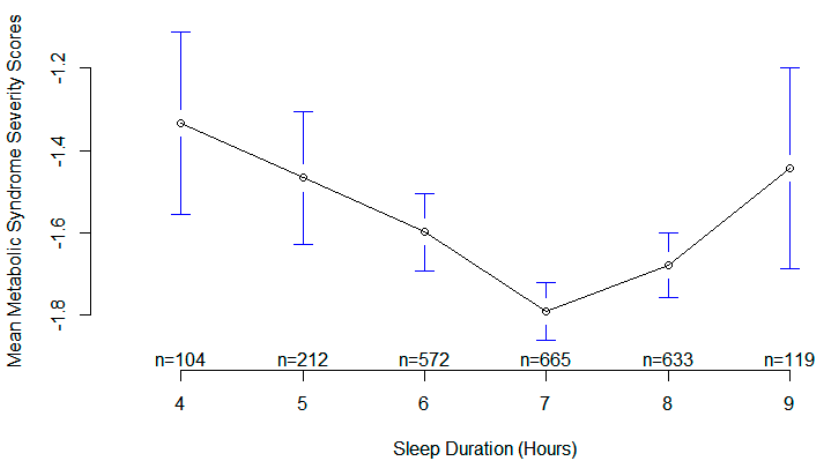
Figure 4. Plots of sleep duration vs. mean metabolic syndrome severity score.